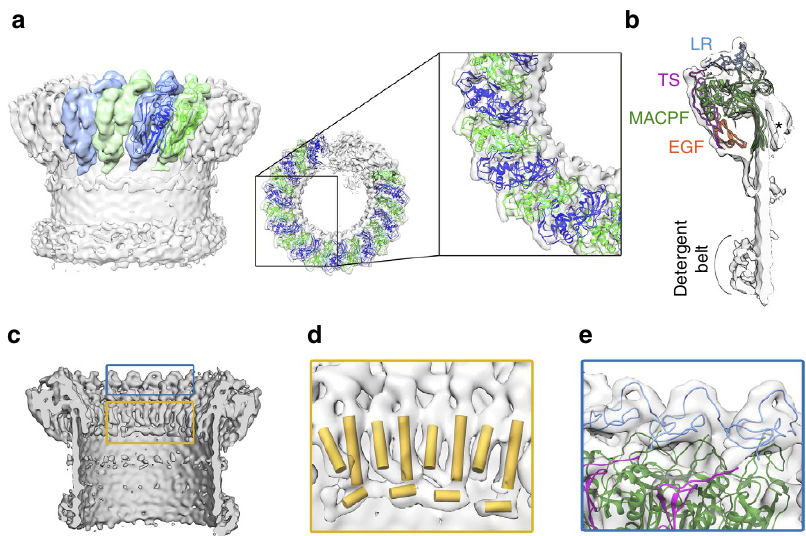
Figure 3 | Organization of C9 in the barrel map. ( a ) Two views of the C9 homology model (ribbons) fitted into the reconstruction (grey). Alternating monomers are in green and in blue colour for clarity. ( b ) Slab view showing three sequential C9s (ribbons). Asterisk indicates unmodelled helical density on the concave surface of the rim. ( c ) Cross-section of the reconstruction; regions in d and e are boxed. ( d ) a -Helical finger-like densities represented as cylinders. ( e ) Close-up of the LR crown.